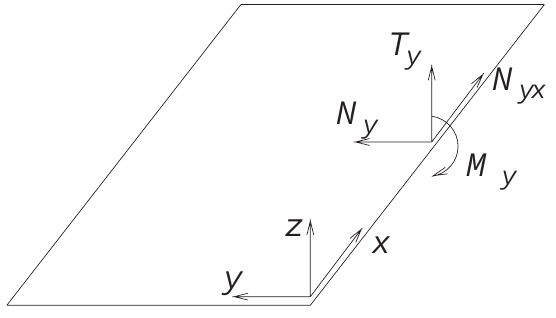
Fig. 2. A panel with its local reference system and corresponding forces (as acting on the